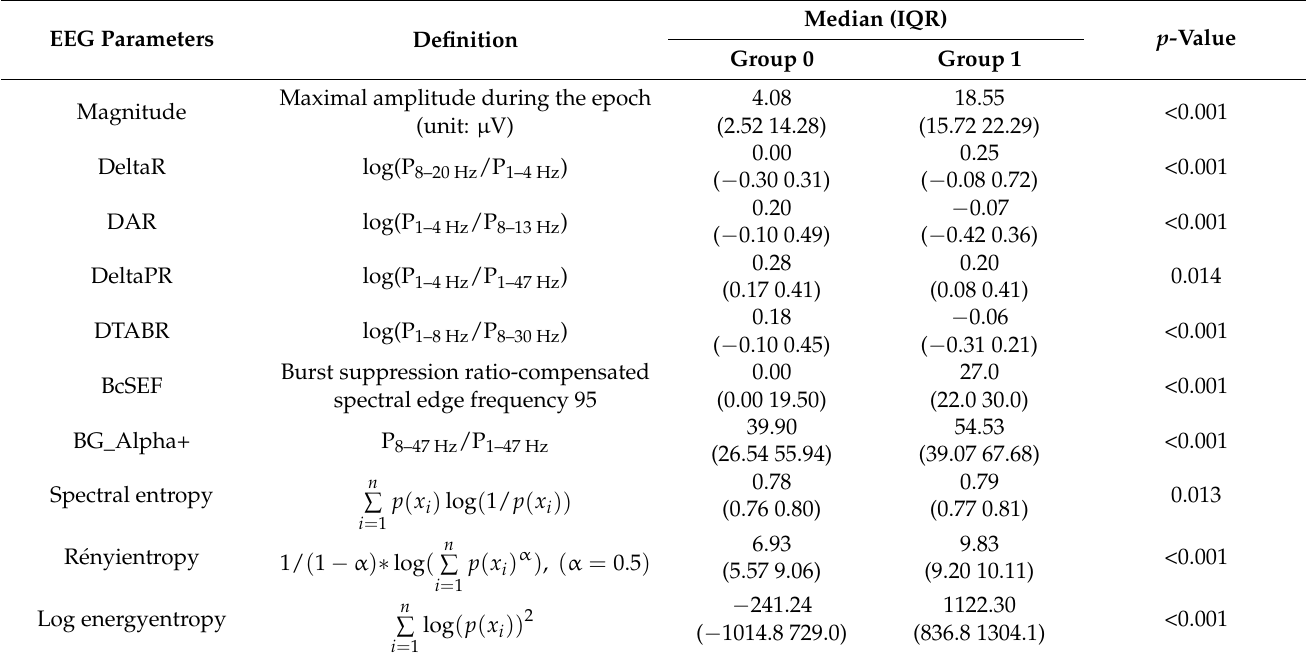
Table 4. Final 10 EEG parameters used to establish the prediction models; definition, median, interquartile range and p-